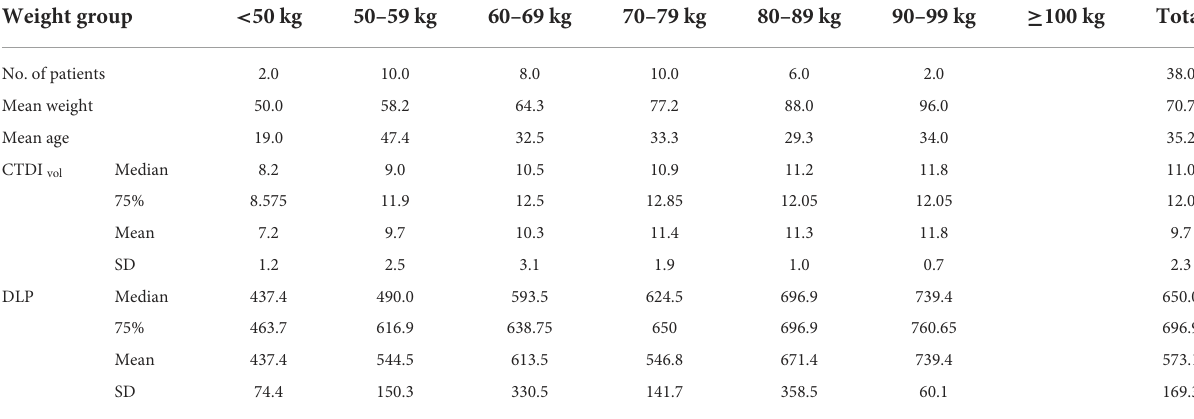
TABLE 7 Distribution of abdomen and pelvis with CM CT for patients in different weight groups.